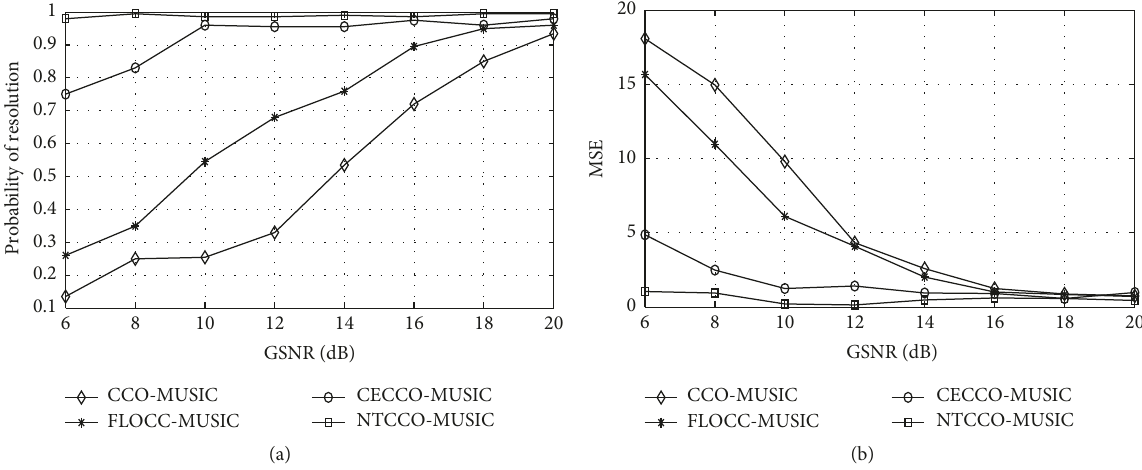
Figure 3: Probability of resolution (a) and MSE (b) versus GSNR.